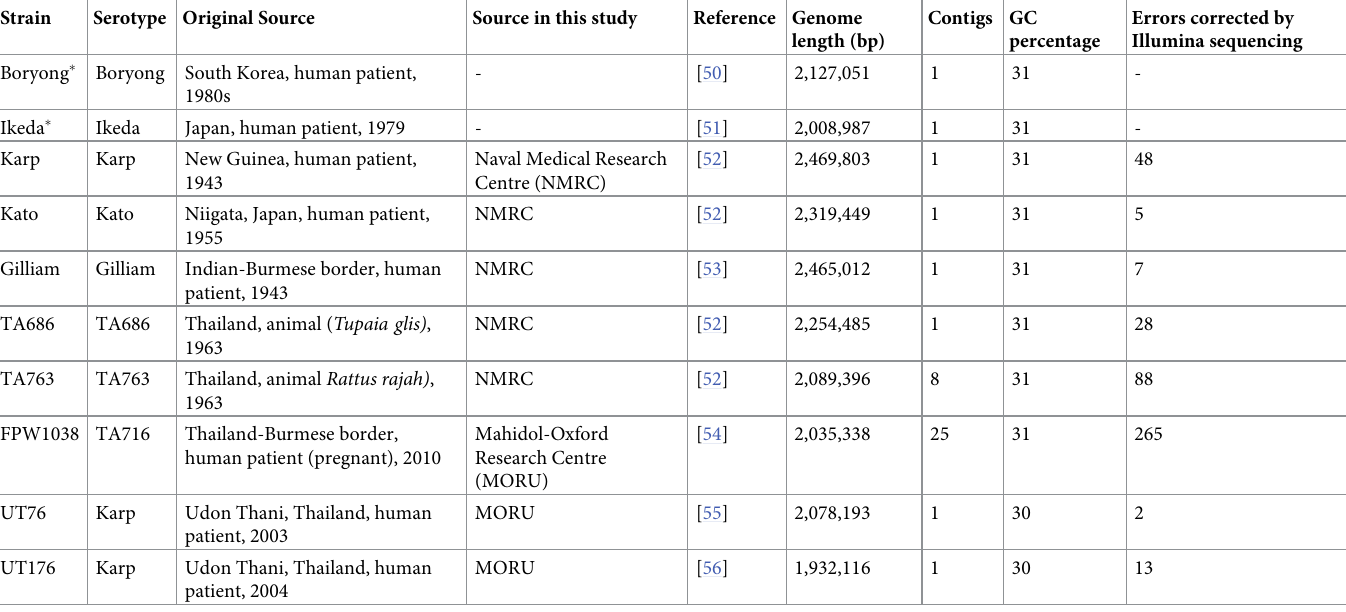
Table 1. Overview of O . tsutsugamushi strains.